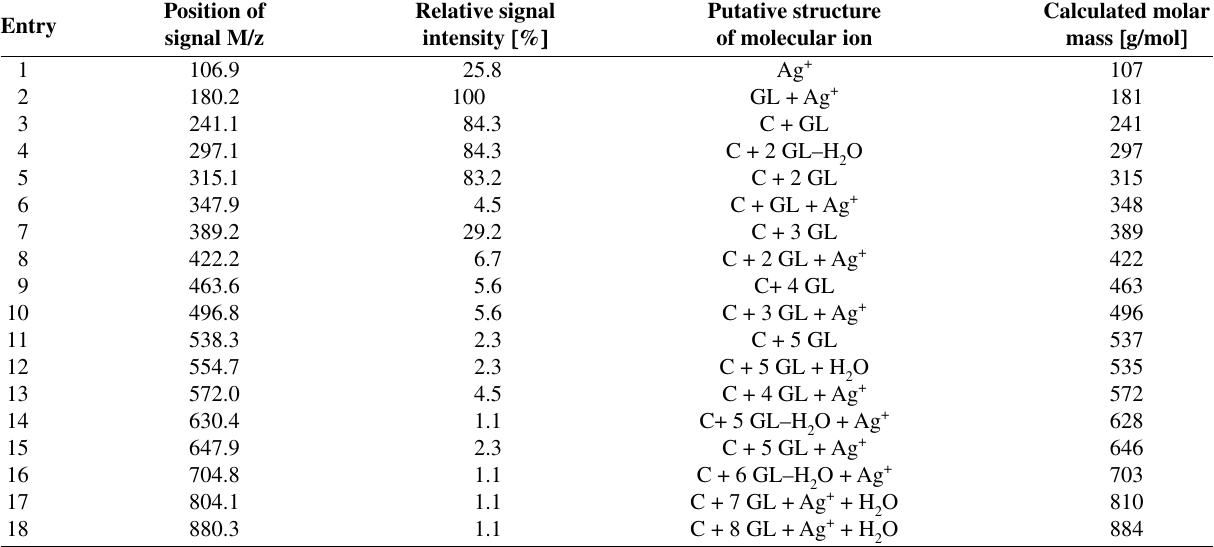
Table 4. MALDI–ToF analysis of product obtained from the C : GL = 1:7 system Position of Relative signal Putative Entry